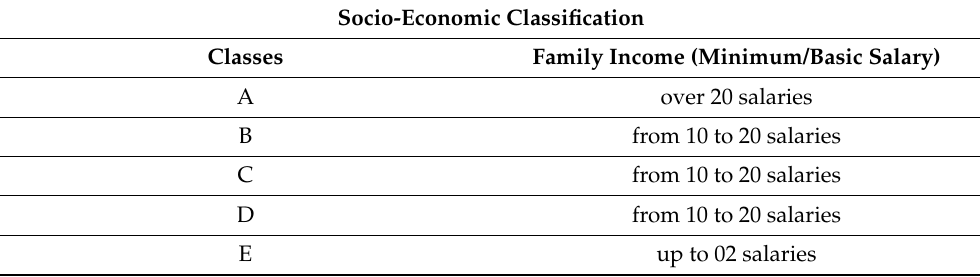
Table 1. Socio-economic classification in the municipality of Bel é m-Par á -Brazil based on minimum salary [IBGE,2012].